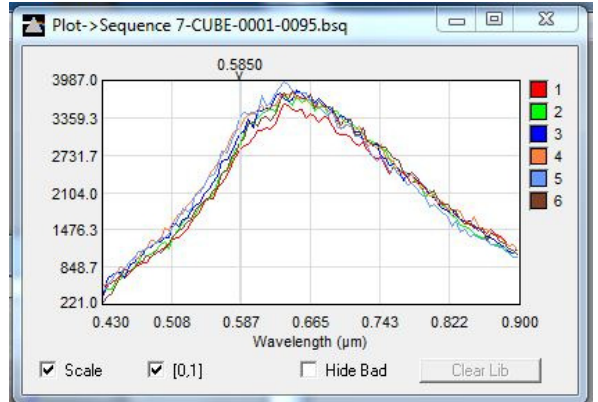
Figure 5. The hyperspectral scene of fragments of archaeological artefacts. The positions used to produce spectral plot are marked by coloured circle and numbered.